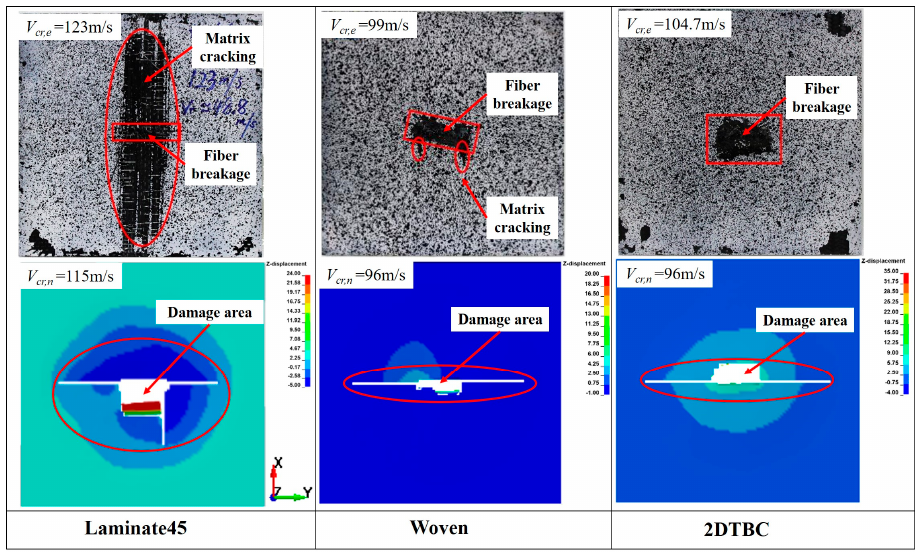
Figure 4. Impact failure patterns obtained by experiments and numerical simulations.